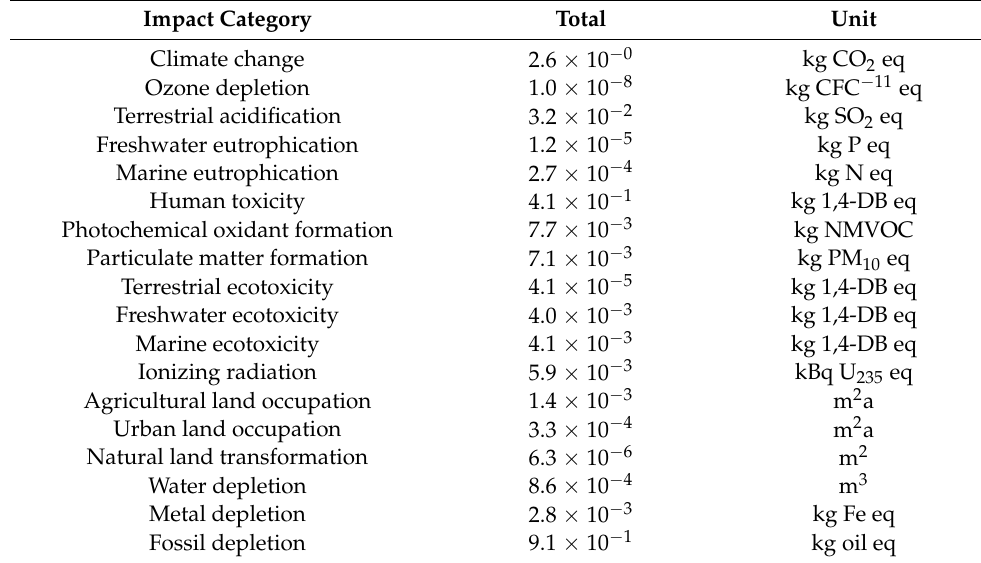
Table 2. Overall impact assessment results for operational